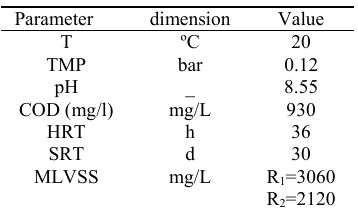
Table 1: operation condition of MBR system Table 1. Operation condition of MBR system Parameter